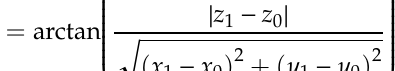
Figure 7. The density distribution of carbon fibers obtained by the method of this paper ( a ) and ( b ),